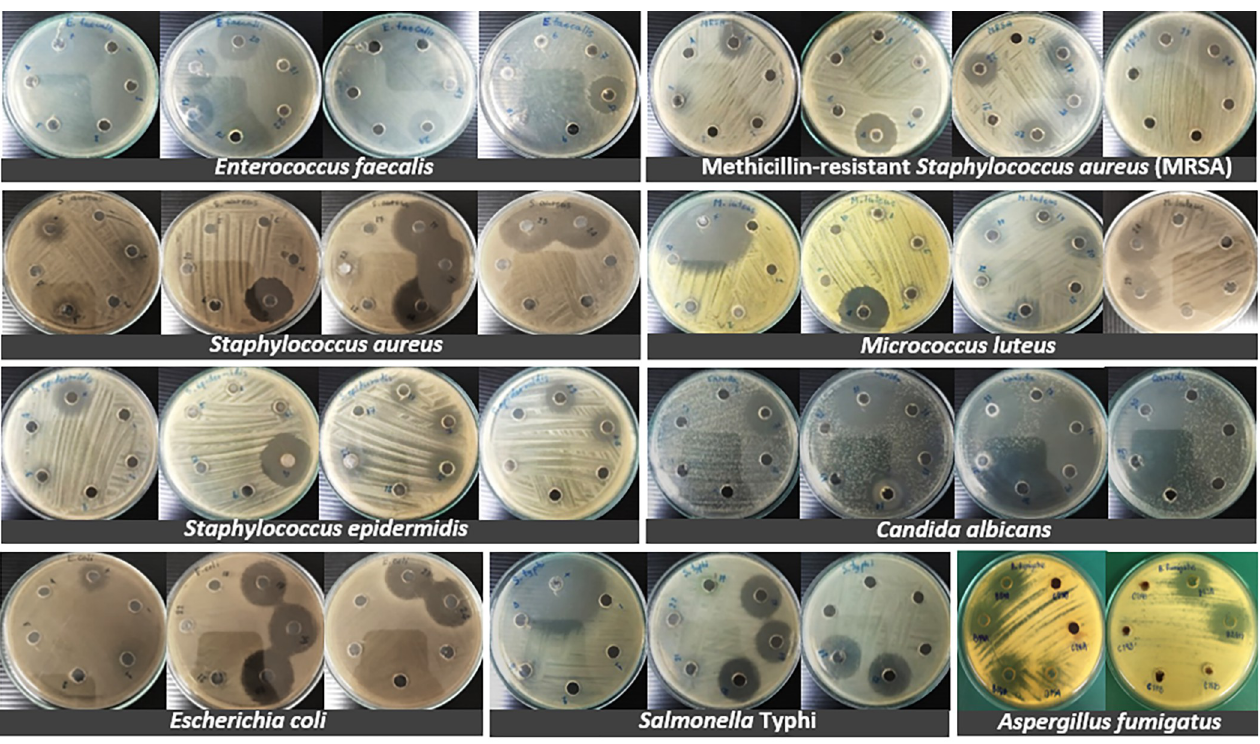
Fig 6. Antimicrobial activity test. Antimicrobial activity of active fungal isolates was determined by the agar well diffusion method. Culture broth filtrates of 80 μ l were tested against pathogenic bacteria and fungi. Fungal filtrates exhibited large zones of inhibition for both Gram-positive ( E . faecalis , M . luteus (ATCC9341), S . aureus (ATCC25923), S . epidermidis , methicillin-resistant S . aureus (MRSA)) and Gram-negative ( E . coli (ATCC25922) and S . Typhi (ATCC19430)) bacteria, including pathogenic yeast ( C . albicans (ATCC90028),) and fungi ( A . fumigatus AF293).